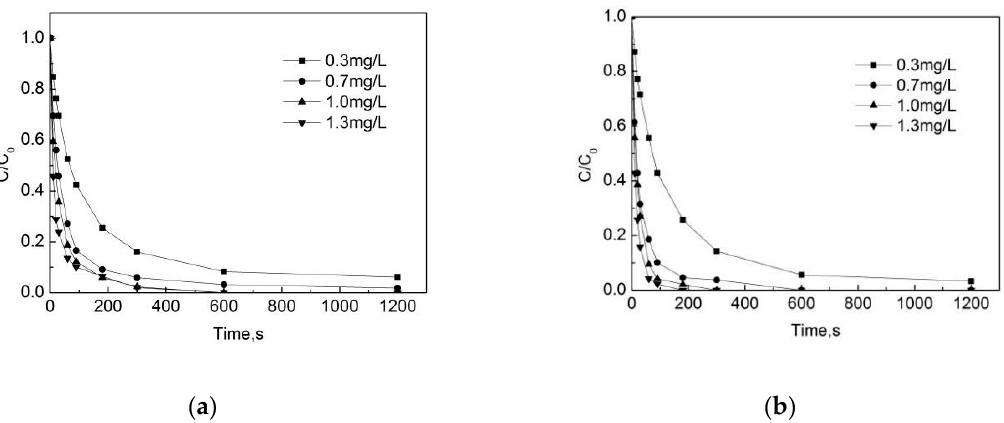
Figure 2. Degradation of Ofloxacin (OFL) under different free chlorine concentrations in ( a ) the water distribution system and in ( b ) deionized water. [C] represents the concentration of OFL at different reaction times, and [C 0 ] represents the initial OFL concentration.